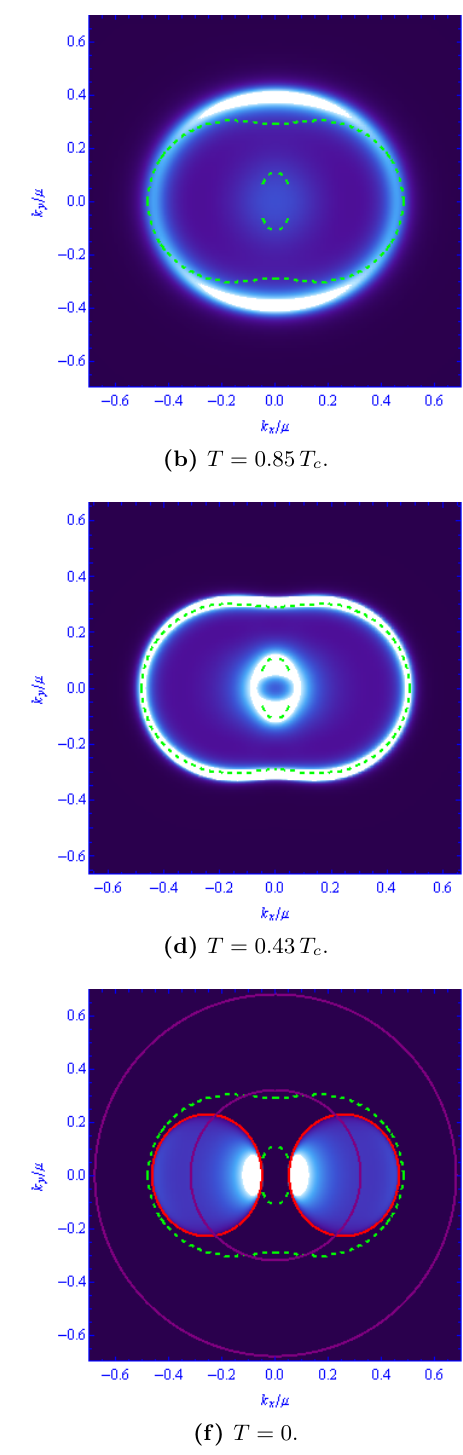
Figure 6. The spectral function for di(cid:11)erent temperatures and (cid:12)xed (cid:21) = 0 : 40 < (cid:21) c , ! = 0 : 18 (cid:22) . It is observed the presence of spherical symmetry at T = T c . The dashed lines indicates the locus of the normal modes. The purple and red circles represent the UV and IR Dirac cones respectively.